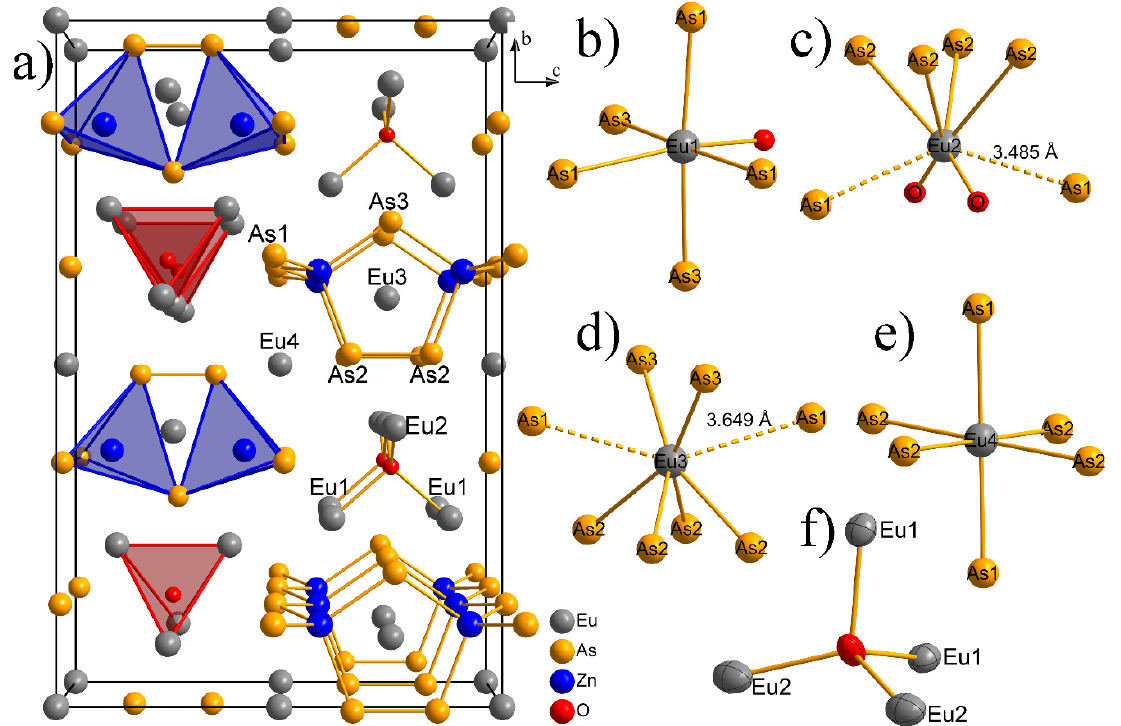
Figure 1. ( a ) Combined polyhedral / ball-and-stick view of the crystal structure of Eu 5 Zn 2 As 5 O, viewed down the a -axis. The unit cell is outlined. ( b–e ) Coordination environment of Eu atoms in Eu 5 Zn 2 As 5 O structure. ( f ) Coordination polyhedron of the O atom. Thermal ellipsoids for O and Eu atoms are plotted at the 95% probability level. Table 3. Selected bond distances in Eu 5 M 2 As 5 O ( M = Zn, Cd). Atom